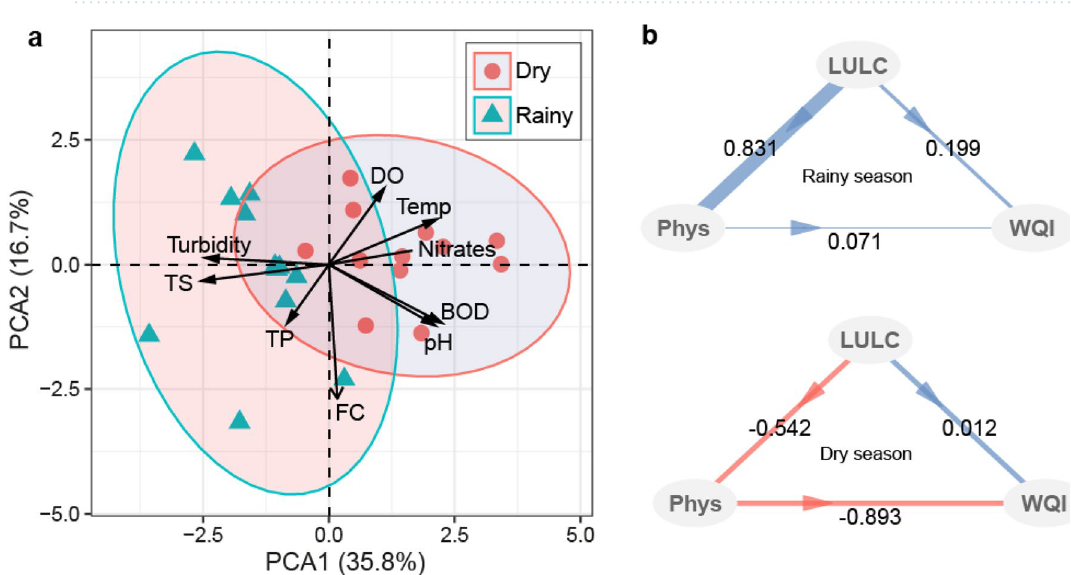
Figure 5. Principal component analysis of all sampled water quality parameters ( a ) and the correlation between land-use types, water quality parameters, and water quality index in seasons ( b ). Source: authors´ self- implementation with R software version 4.0.0 (https:// www.r- proje ct.